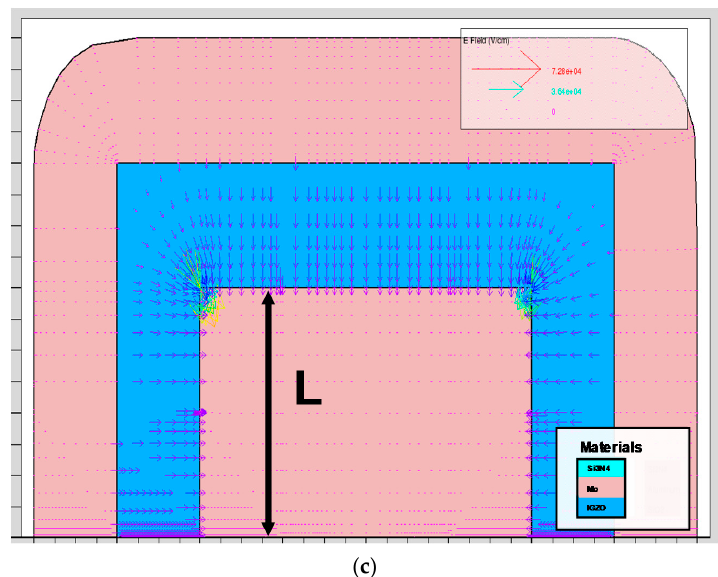
Figure 5. Simulated electric field stress (E-field) distribution from device structures with ( a ) larger ρ (round corner), ( b ) small ρ , and ( c ) ρ = 0 (perpendicular corner). The distribution of E-field was focused and the magnitude was enhanced at the corner region of the channel, especially for devices with a smaller ρ .